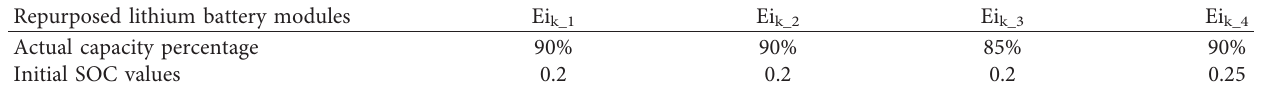
Table 2: Simulation parameters of repurposed lithium batteries in charge and discharge states. Repurposed lithium battery modules